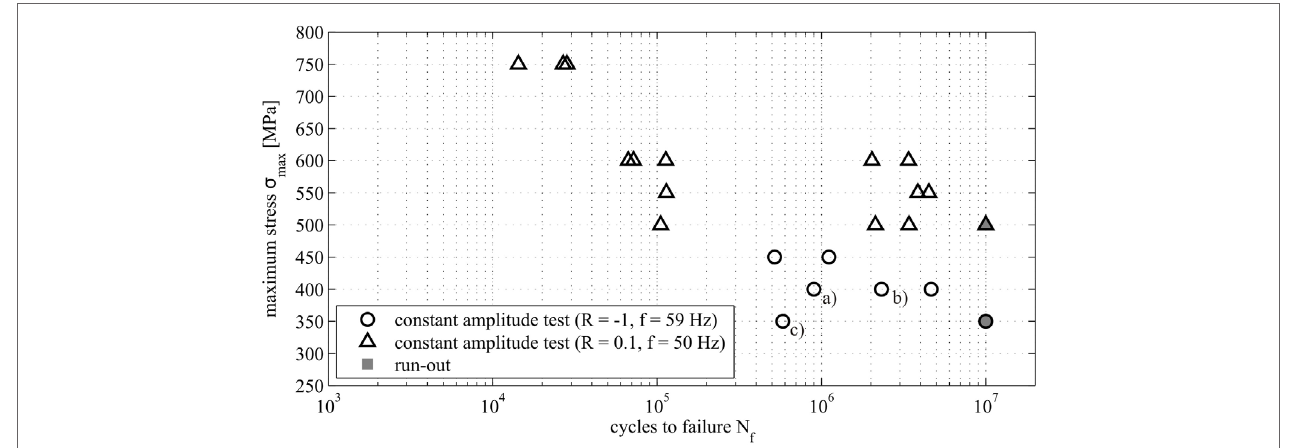
FigUre 2 | high cycle fatigue properties of stress-relieved Ti–6al–4V under tension–tension and tension–compression loading